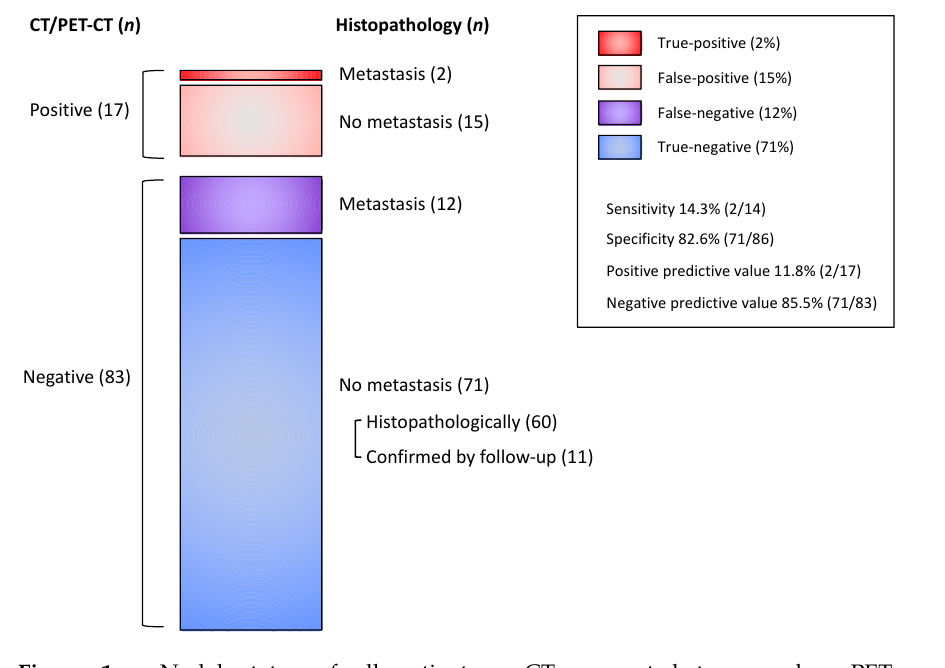
Figure 1. Nodal status of all patients. CT, computed tomography; PET, positron emission tomog- raphy .